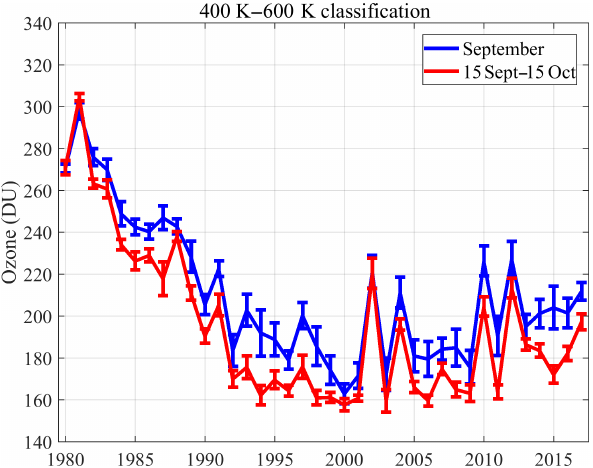
Figure 3. As in Fig. 2 but only for 400–600K classification on dif- ferent periods: September and mid-September to mid-October. Er- ror bars represent 2 σ .